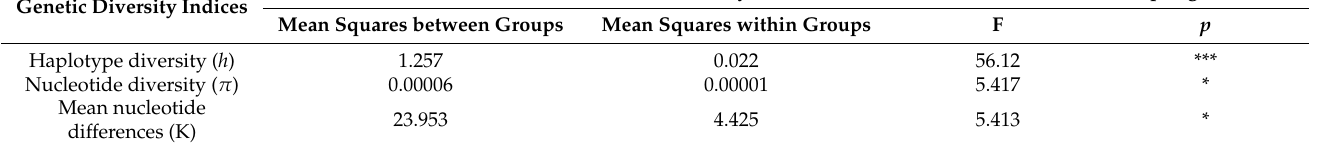
Table 5. Statistical comparisons of genetic diversity levels among populations of the blue crab Callinectes sapidus from native and invaded sampling sites (as indicated in Table 4) by means of one-way analysis of variance (one-way ANOVA). F: F-statistic defined as the ratio of the variance calculated among the means to the variance within the samples. * Significant difference at p < 0.05; *** Significant difference at p <